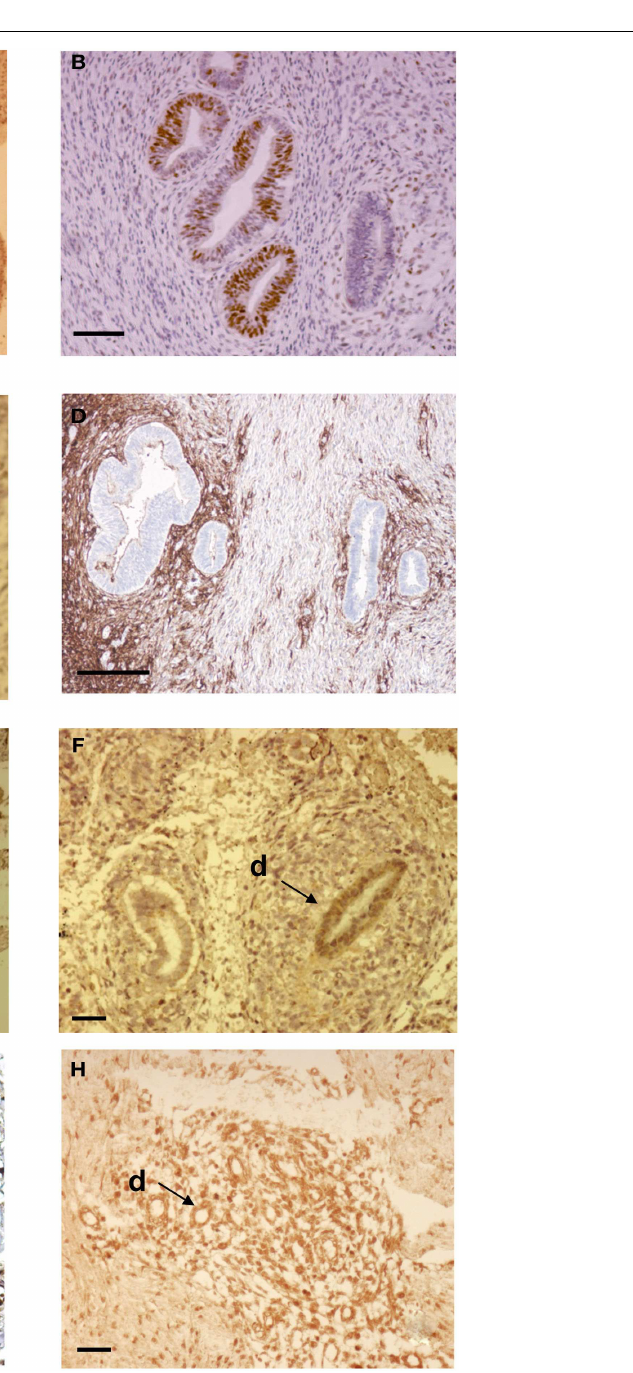
FIGURE 3 | Immunohistochemical analysis of ectopic endometrial glands and embryonic ducts in fetal reproductive tract. Immunolabeling with anti PR antibody of uterine cavity wall lining cells [ (A) , arrows]. Immunostaining of the fetal ectopic glands located in the uterine myometrium with anti PR (B) , anti ER- α (C) , and anti CD10 antibodies (D) .